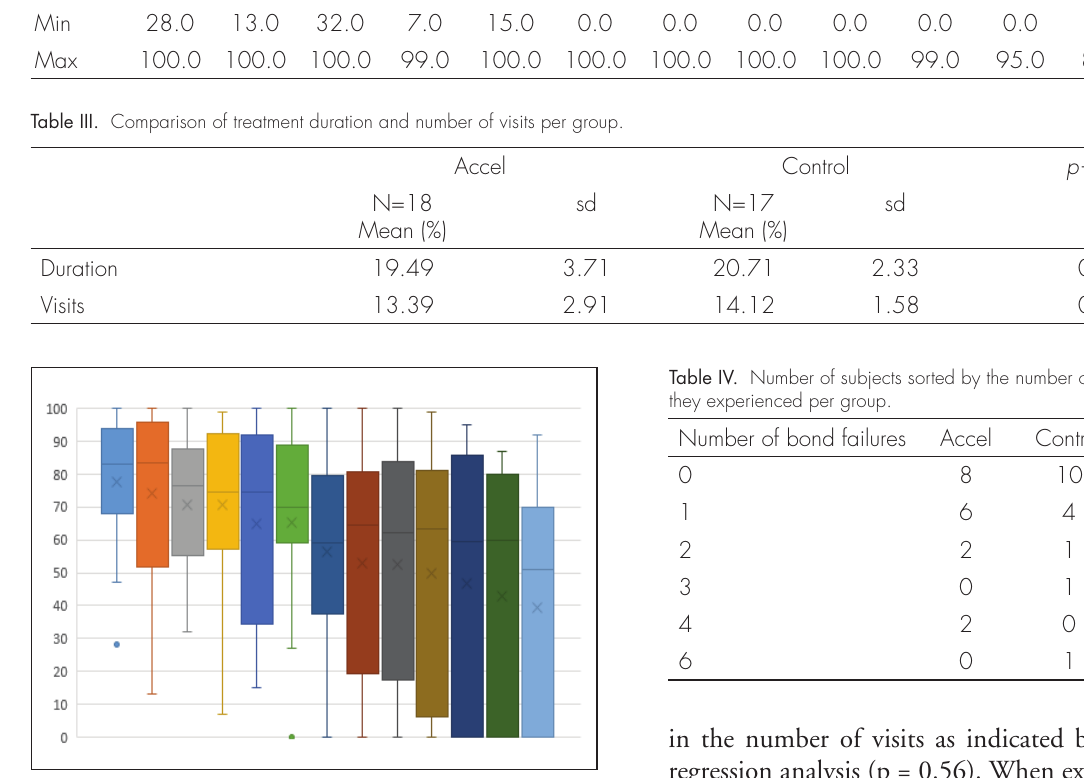
Figure 2. AcceleDent usage data per every 30 days over ~13 months. The range, interquartile range (solid bars), mean (X) and median (horizontal line) are indicated. Figure 3. Histogram of the number of visits for the AcceleDent and control groups demonstra?ng a larger spread in the number of visits for AcceleDent.